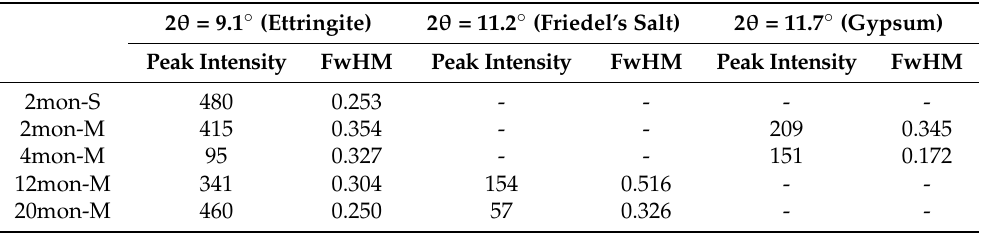
Table 5. Peak intensity and Full width at half maximum (FwHM) of hydration products formed in samples after marine tidal exposure via the XRD